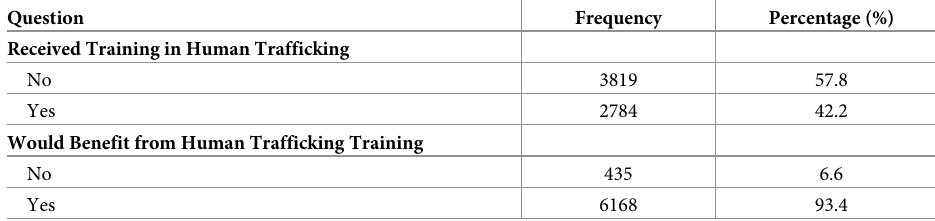
Table 3. Responses to human trafficking training